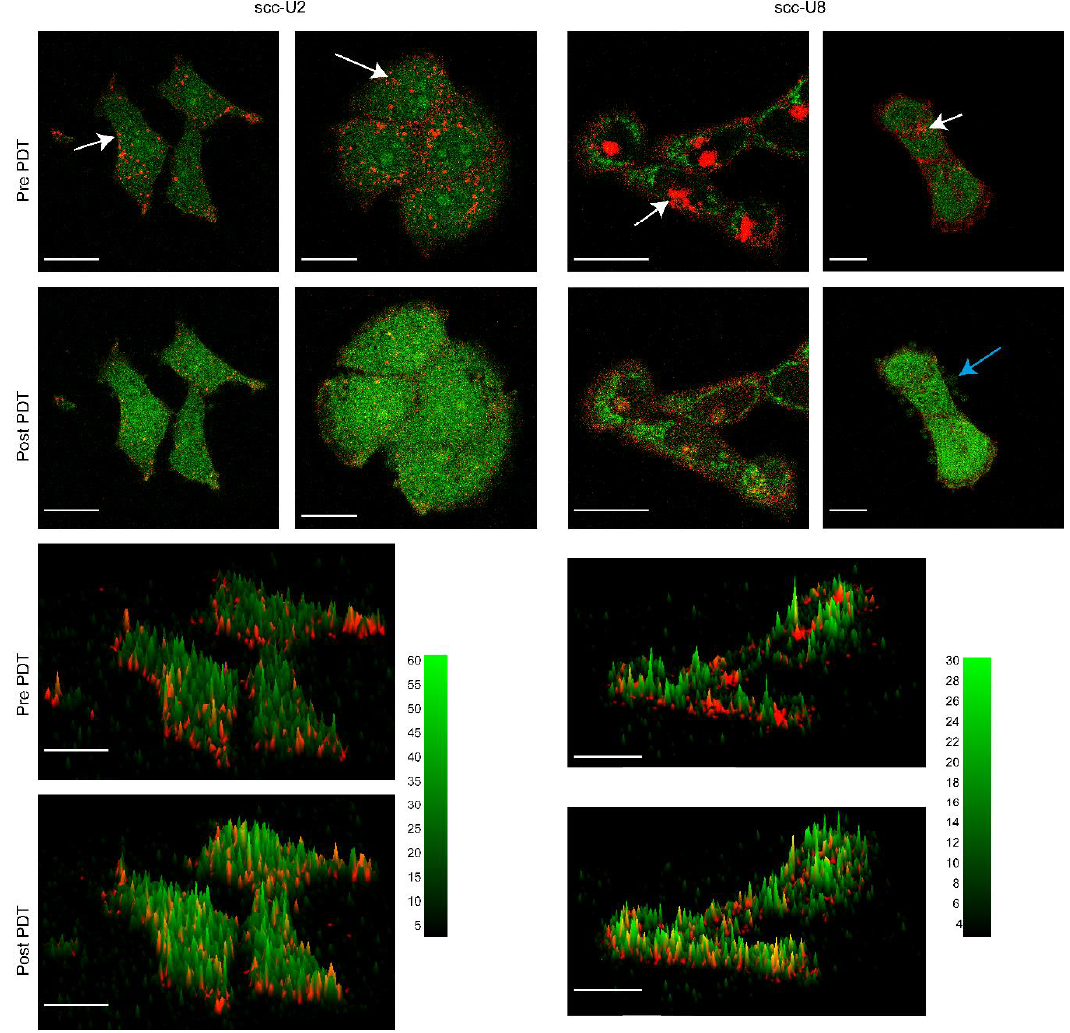
Figure 3. Examples of 2D images and 3D surface plots from images collected pre and post PDT of scc-U2 and scc-U8 cells incubated with cetuximab-IRDye700DX for 24 h and singlet oxygen sensor green (SOSG) for 2 h. White arrows point to some of the endo/lysosomes showing cetuximab-IRDye700DX fluorescence. Blue arrow point to blebs formed in response to the PDT treatment. Bar is 20 µm. Height of the peaks correspond to the fluorescence intensities of SOSG (green).